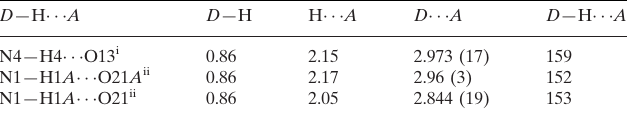
Hydrogen-bond geometry (A˚ , (cid:4)